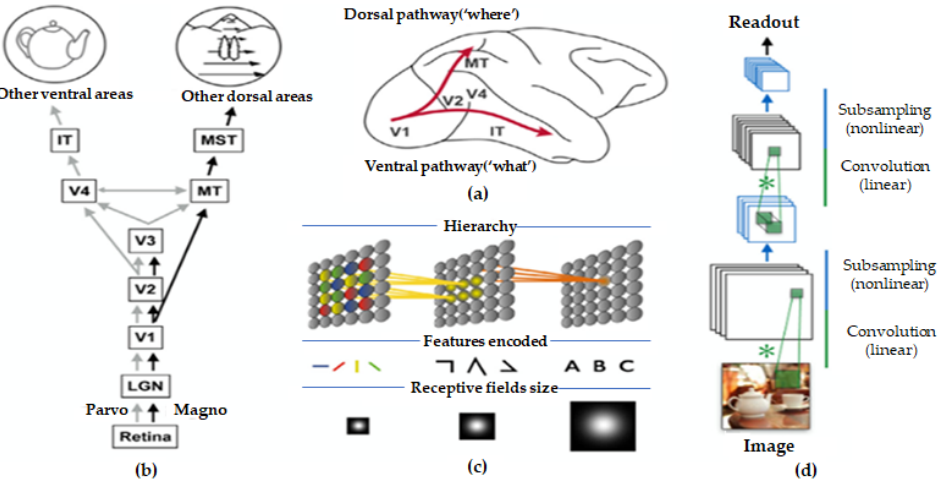
Figure 1. The classical view of hierarchical feedforward visual processing. ( a , b ) show the vision path that flows from the retina to the primary visual cortex (area V1) through two parallel retino–genicular–cortical pathways and ( c , d ) show the CNN structures.